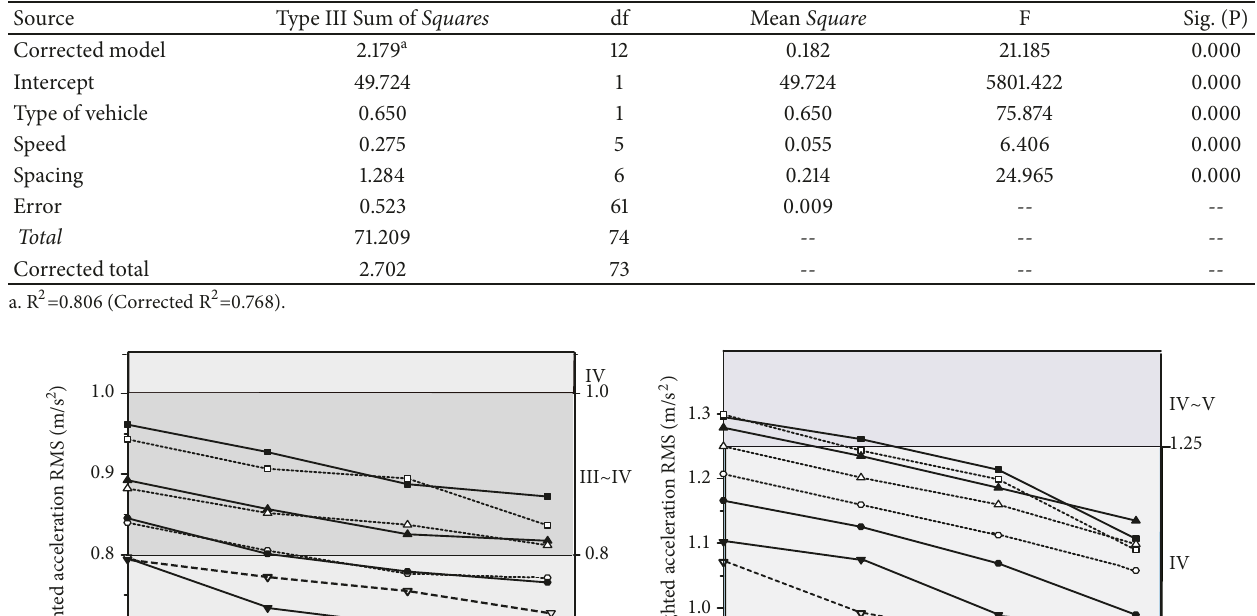
Table 6: Main effect test. The dependent variable: the combined total weighted acceleration RMS.